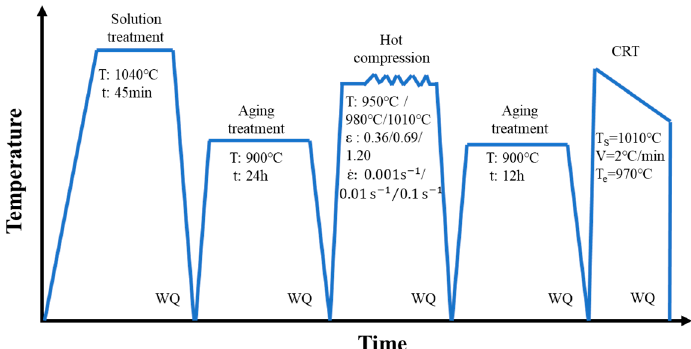
Figure 3. Experimental process for the whole test (WQ represents water quenching).